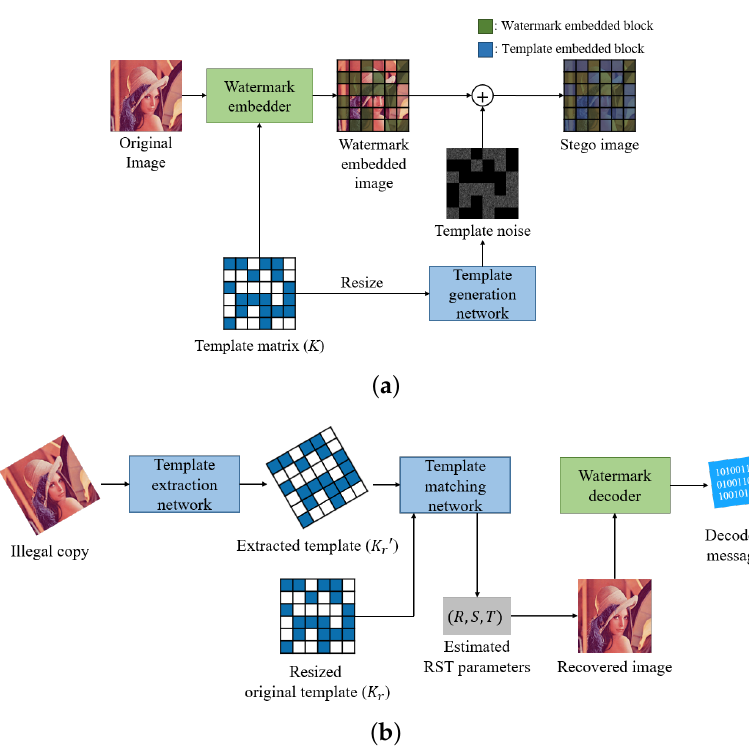
Figure 2. An overview of the proposed method. ( a ) insertion step, and ( b ) decoding step. A Stego image is an image in which both a watermark and a template are